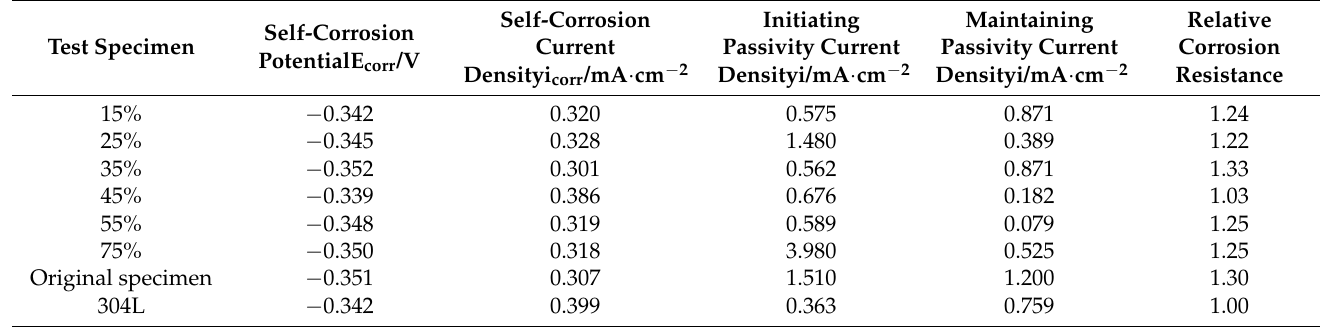
Table 3. Electrochemical corrosion test results of different specimens in a 5% H 2 SO 4